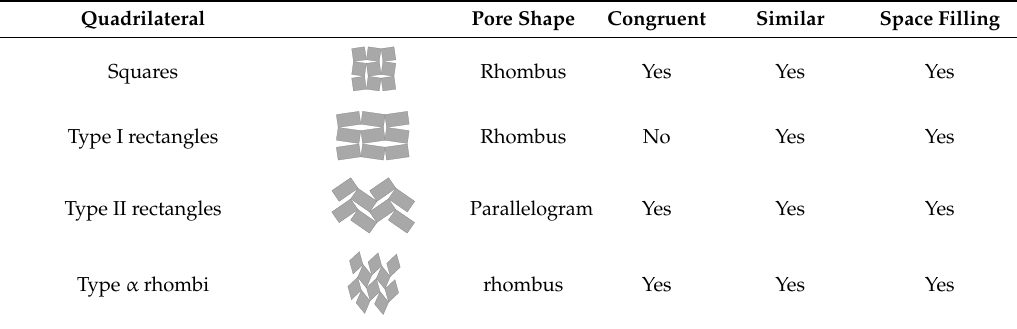
Table 1. Comparison of pore shape and size for rotating rigid quadrilateral networks. Quadrilateral Pore Shape Congruent Squares